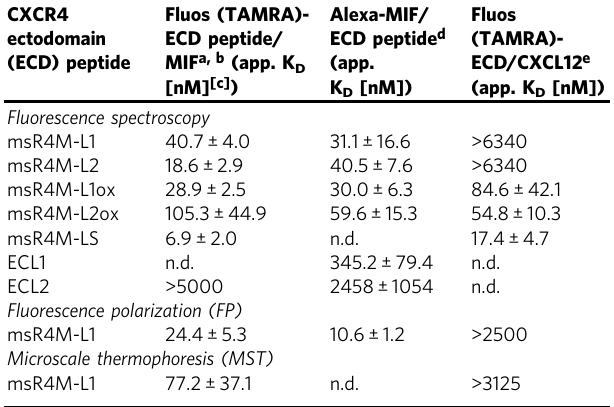
Table 1 Binding af fi nities between the CXCR4 ectodomain peptides and MIF versus CXCL12 as determined by fl uorescence titration spectroscopy, fl uorescence polarization (FP), and microscale thermophoresis